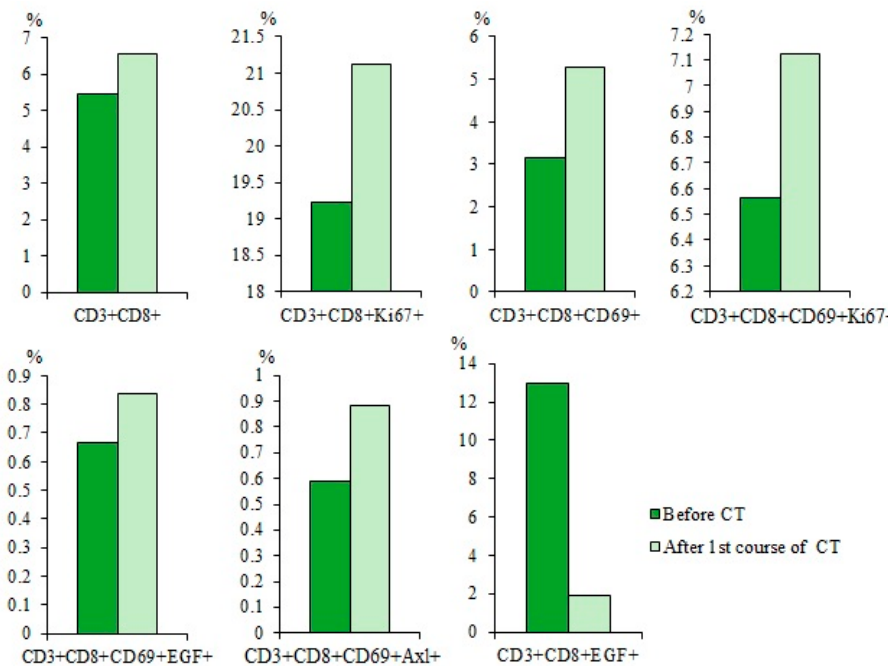
Figure 13. The content of CD3 + CD8 + , CD3 + CD8 + Ki67 + , CD3 + CD8 + CD69 + , CD3 + CD8 + CD69 + Ki67 + , CD3 + CD8 + CD69 + EGF + , CD3 + CD8 + CD69 + Axl + , and CD3 + CD8 + EGF + T-lymphocytes in the blood of SCLC patients G before and after the first course of chemotherapy (CT) (% of all labelled mononuclear cells). Cells were analyzed by flow cytometry using antibodies against CD3, CD8, CD69, EGF, Axl, and Ki67.